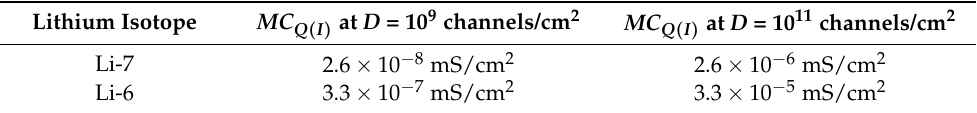
Table 17. The table shows that intracellular lithium isotopes can have a range of quantum membrane conductance from the value at D = 10 9 channels/cm 2 to the value at D = 10 11 channels/cm 2 according to the setting values in graph (c) of Figure